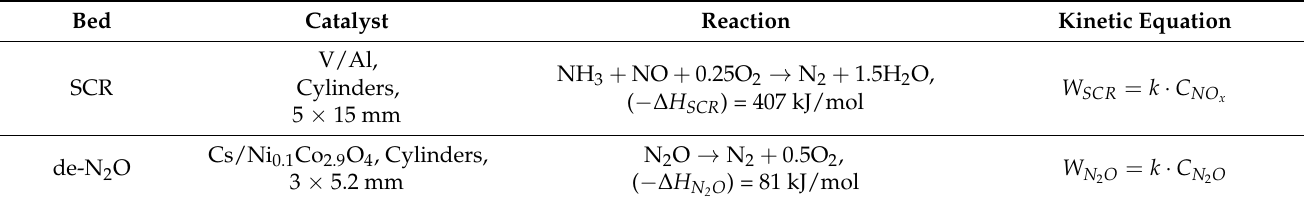
Table 6. Catalyst dimensions, stoichiometric equations, enthalpies, and kinetic